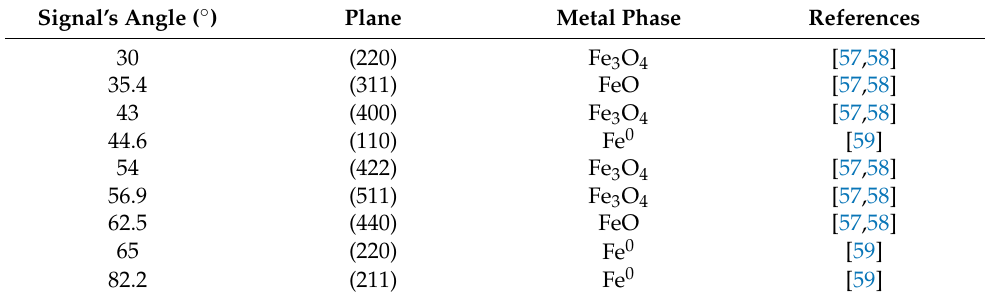
Table A1. XRD planes identifications in spent Fe/CAG.